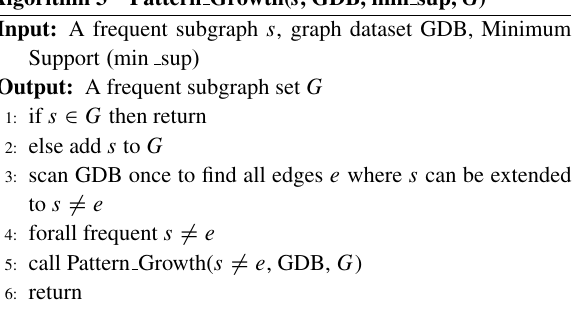
Fig. 11 Pattern growth-based extension. Algorithm 3 Pattern Growth( s , GDB, min sup, G )